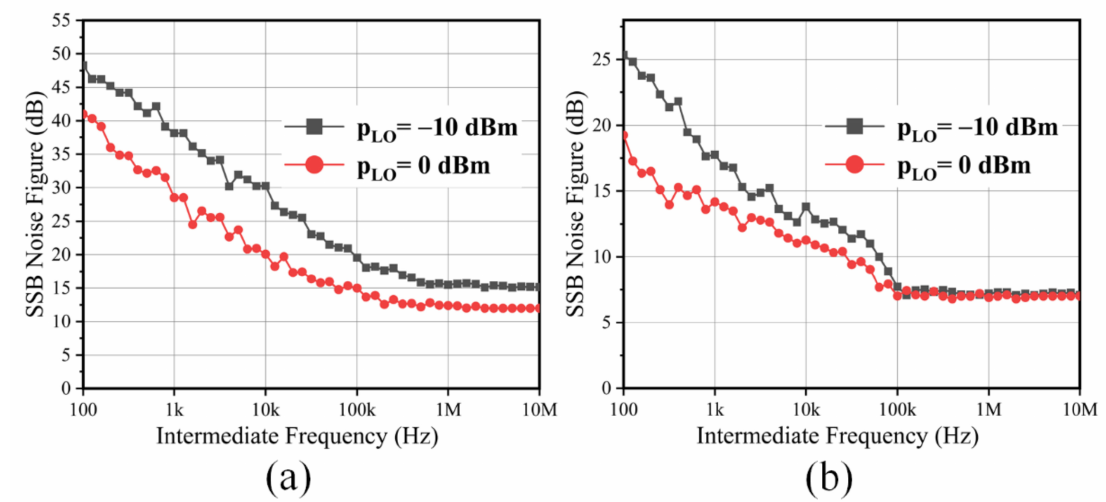
Figure 10. ( a ) Flicker noise results of mixer; ( b ) flicker noise results of receiver.